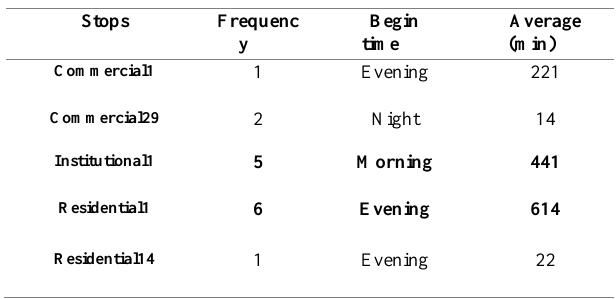
Table 7. Some semantic features in stop ontology.